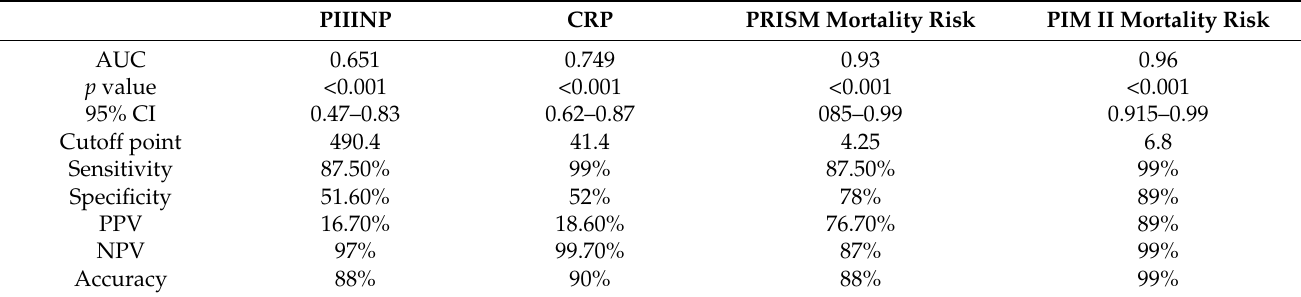
Table 6. Validity of PIIINP, CRP, PRISM and PIM for prediction of mortality.